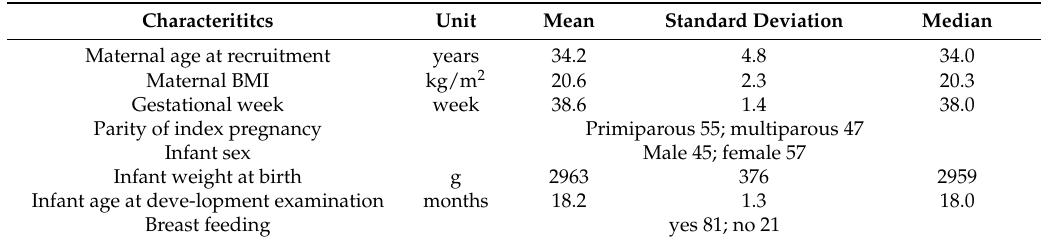
Table 1. Demographic characteristics of the mother and her infant of the present study ( n =